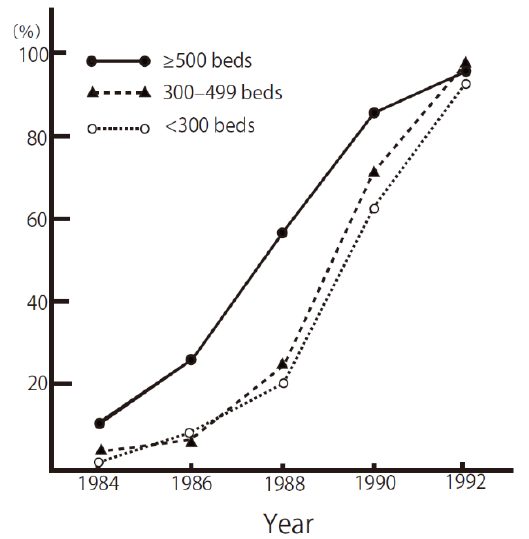
Figure 1. Proportion of hospitals with MRSA isolation, 1984–1999, based on a questionnaire survey of hospitals in Japan. Translated into English from reference [4] with permission.